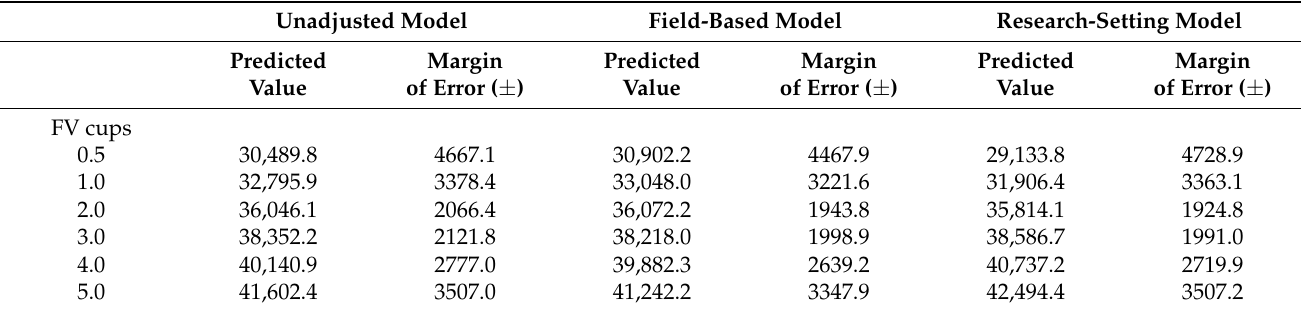
Figure 1. Resonance Raman spectroscopy (RRS) scores predicted by reported FV consumption among children under three scenarios ( n = 177). FV cups were modeled from 24 h recall data. The unadjusted model included no covariates. The field-based model included adjustments for age, race, ethnicity, state, and a smoker in the household. The research-setting model included all covariates in the field-based model with additional adjustment for BMI-for-age percentile, energy intake, and fat intake. Error bars presented are from the research-setting model. Table 3. Predicted RRS scores for discrete FV consumption levels among children under three scenarios ( n =